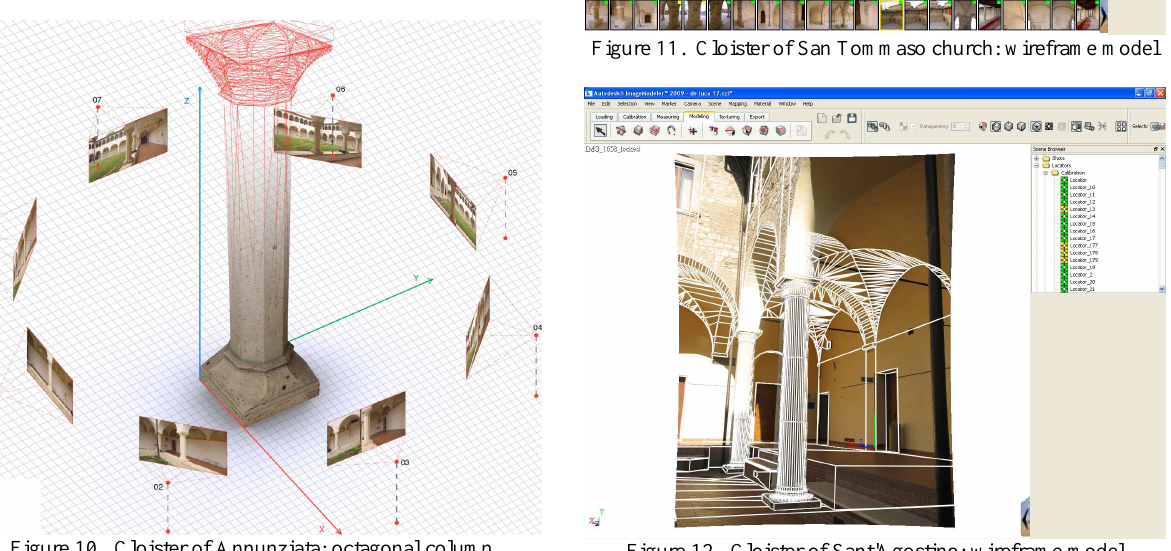
Figure 9. Cloister of Annunziata: orientation of the cameras